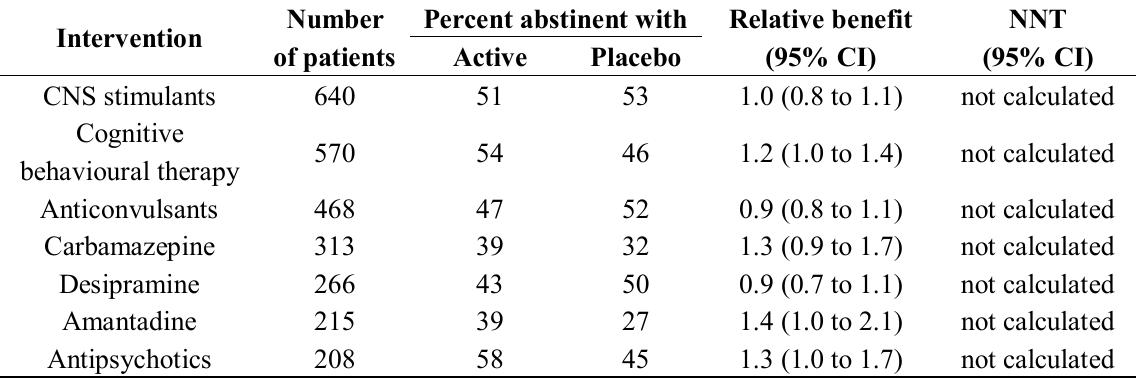
Table 5. Results of cocaine cessation reviews, ordered by number of participants. The order is by numbers of participants in the reviews. Intervention is as described in each review, and details of the reviews is in Table